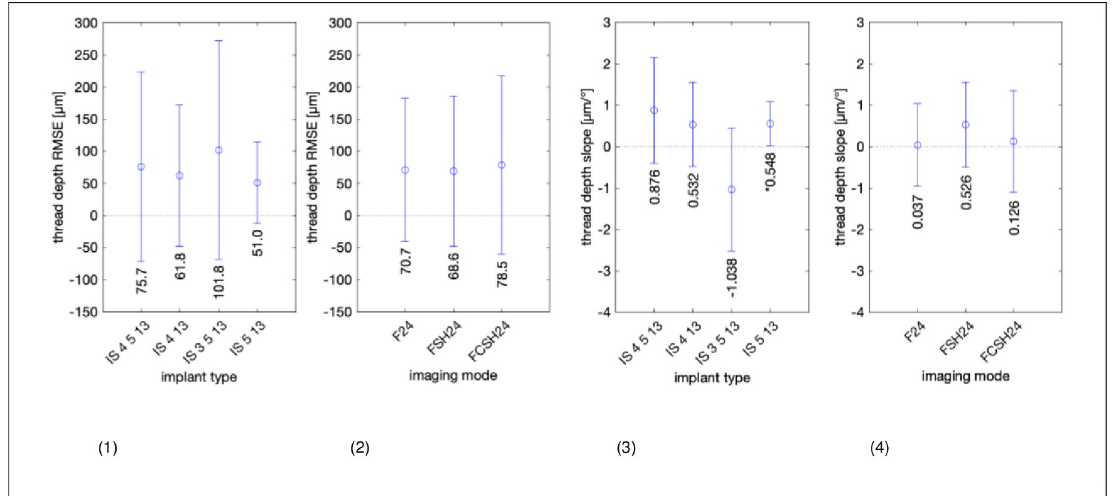
Fig 11. RMSE in measuring implant thread depth with ultrasound. Left to right: (1) RMSE in micrometers and standard deviation error bars across 3 imaging modes (F24, FSH24, FCSH24) for each of the 4 implant types. (2) RMSE in micrometers and standard deviation error bars across 4 implant types for each of the 3 imaging modes (F24, FSH24, and FCSH24). (3 and 4) Same data as (1 and 2) but as dependence of image angle, i.e., the slope in each subplot combination of implant and imaging mode of S5 Fig.